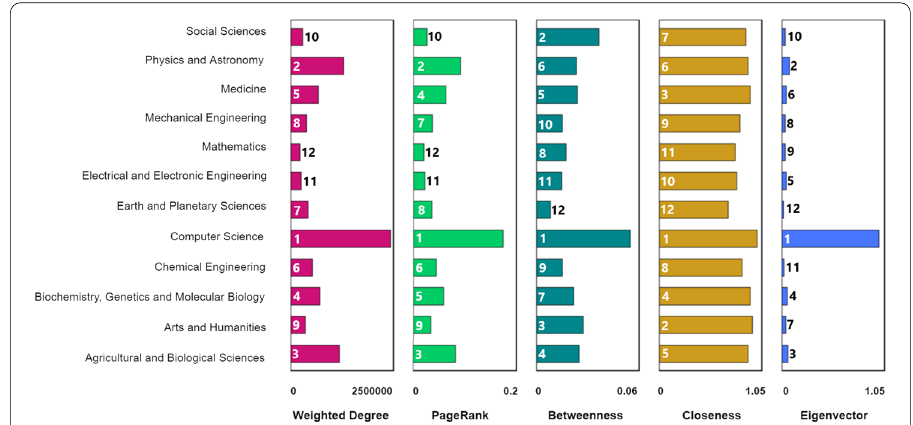
Fig. 5 Centrality measures for the top twelve central nodes of the field of interest graph. Larger values correspond to greater importance. Numbers in the bars give the rankings of these fields of